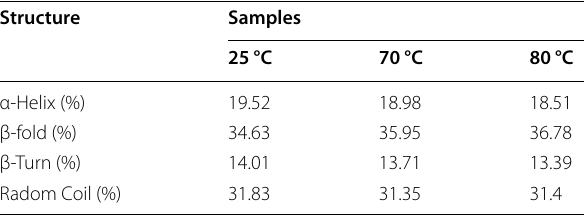
Table 2 Secondary structural element contents of bl-GBE